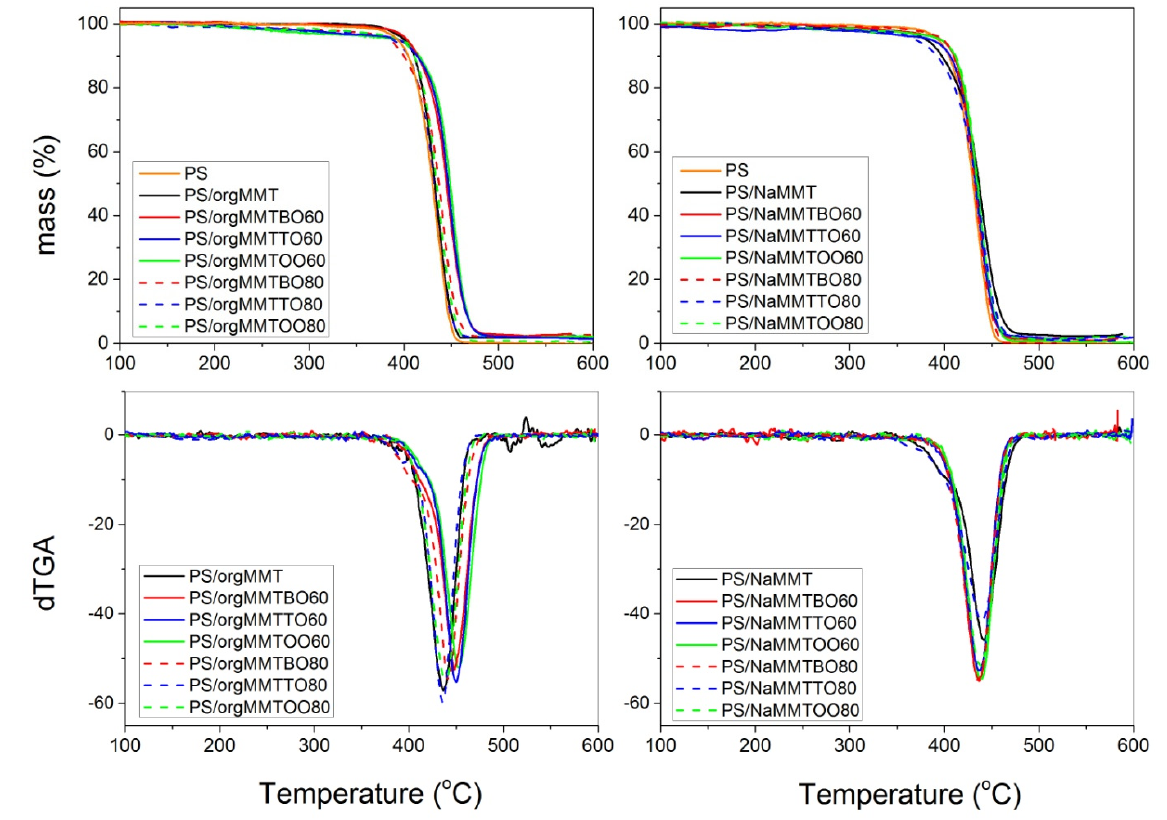
Figure 9. Mass loss and differential thermogravimetric analysis (TGA) curves obtained during heating at 20 °C/min of neat PS and PS/orgMMTEO and PS/NaMMTEO nanocomposites with various types of added essential oils. Table 4. TGA data of neat PS and its nanocomposites with the sodium and orgno-modified MMT with or without the essential oils. Temperatures at 4% and 20% degradation, as well as at the max- imum degradation rate, T 4% , T 20% and T max and residual mass at 600 °C.